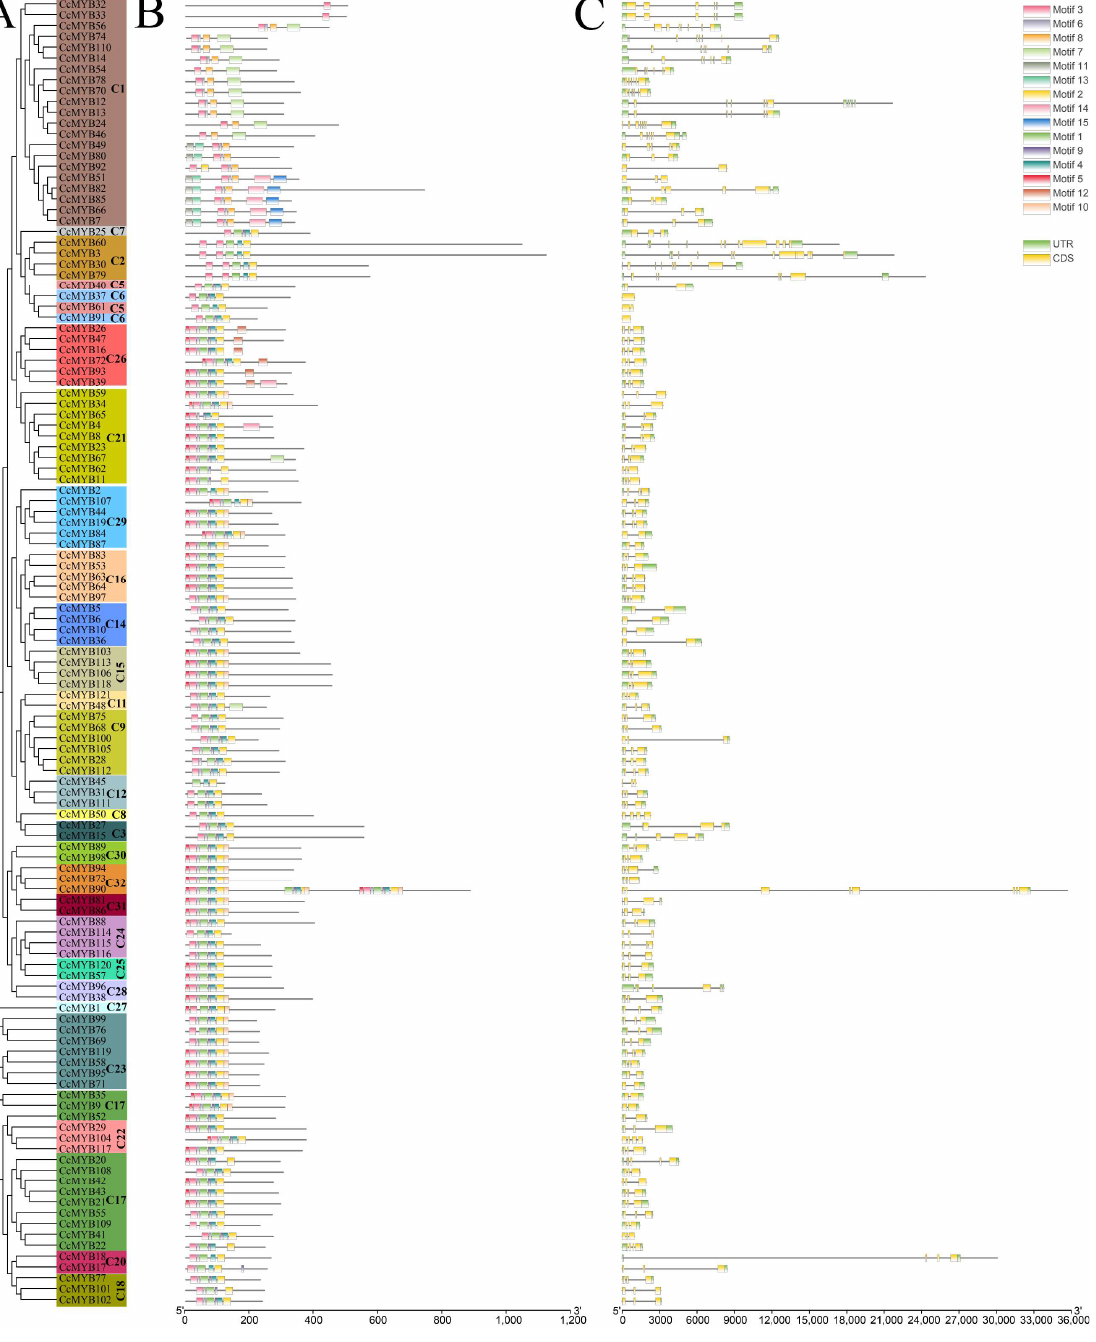
Figure 3. Phylogenetic relationships, motifs and exon–intron structures of CcMYB family members. ( A ) A phylogenetic tree of 121 CcMYB proteins was constructed using the neighbor-joining method. Different subgroups were indicated with different background colors and labels; ( B ) Conserved motifs of CcMYB proteins. Different motifs were indicated by different colored squares; ( C ) exon–intron structure of CcMYB genes. Exons, introns, and UTRs are indicated by yellow boxes, black lines, and green boxes,